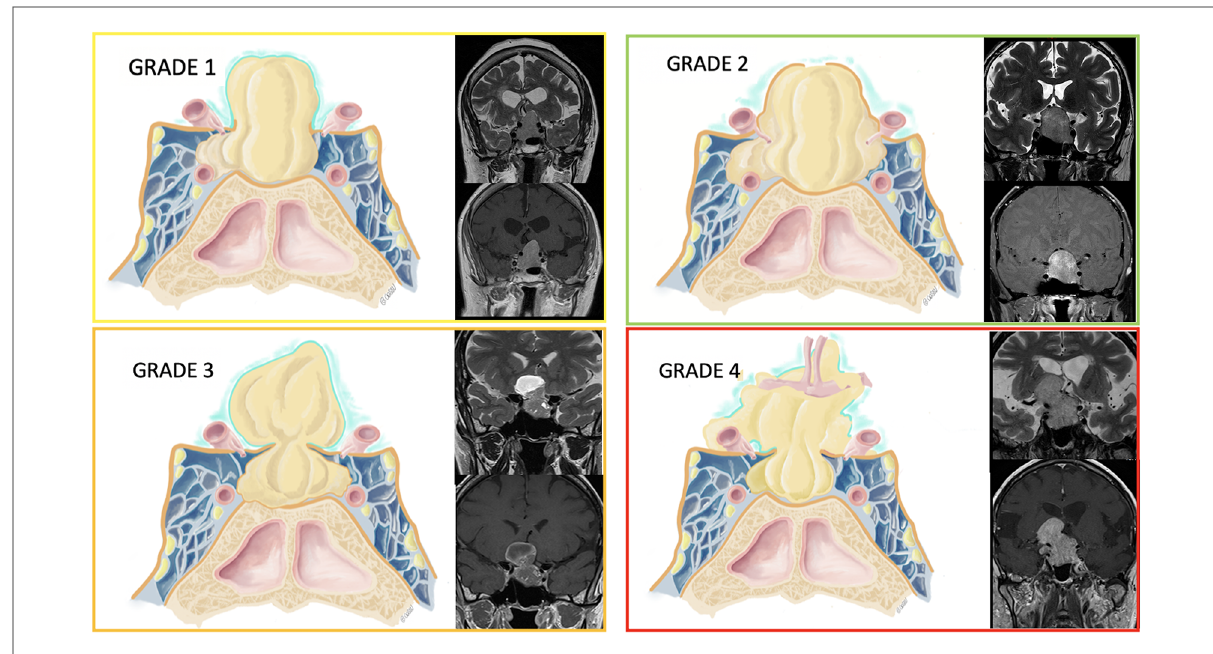
FIGURE 1 Tumors were classi fi ed according to their relationship with the diaphragm. A graphical representation is provided along with some examples of patients ’ MRI on the coronal plane (T2- and T1-weighted sequences after gadolinium